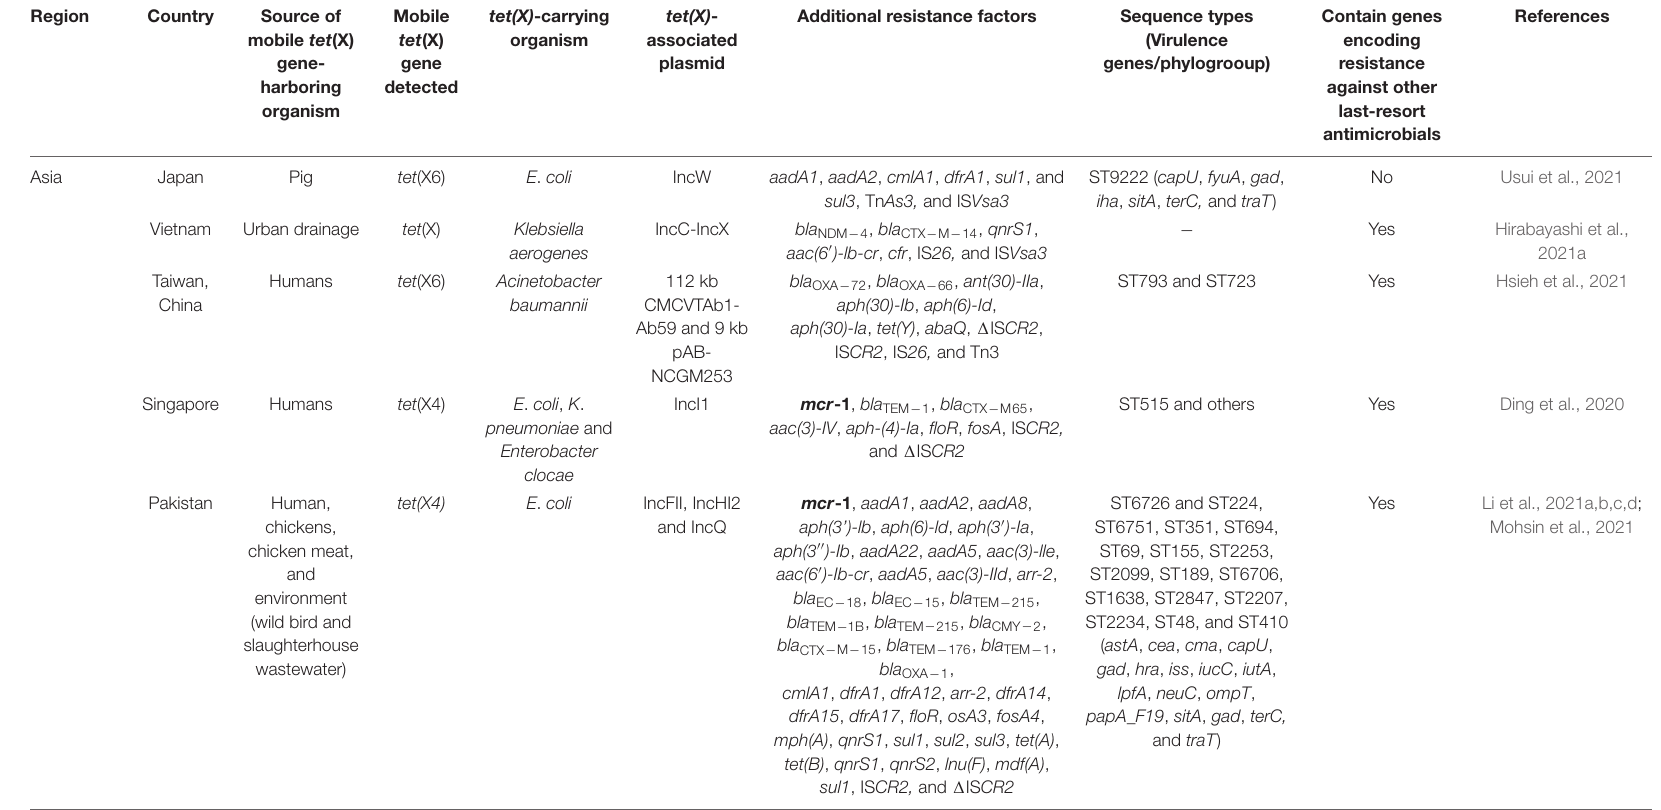
TABLE 1 | Ecological niches in which plasmid-encoded tigecycline resistance tet (X) genes have been detected.